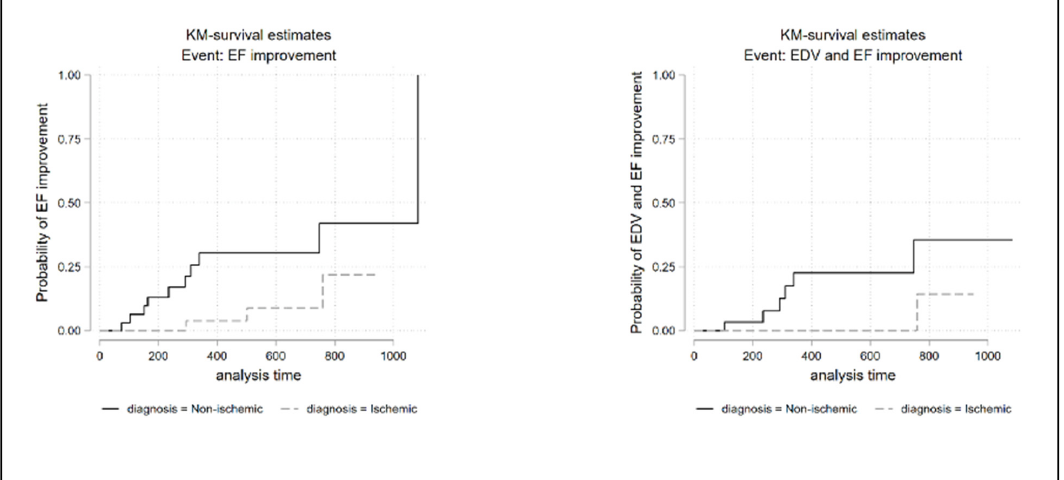
Figure 2. Kaplan–Meier survival analysis and log rank test. Functional LV improvement (EF improve- ment) and combined outcome of favorable LV remodeling/functional LV improvement (EDV and EF improvement) were significantly higher in non-ischemic group (P log rank test for EF improvement = 0.0224; P log rank test for EDV and EF improvement = 0.0215). LV = left ventricle, EDV = end diastolic volume, EF = ejection